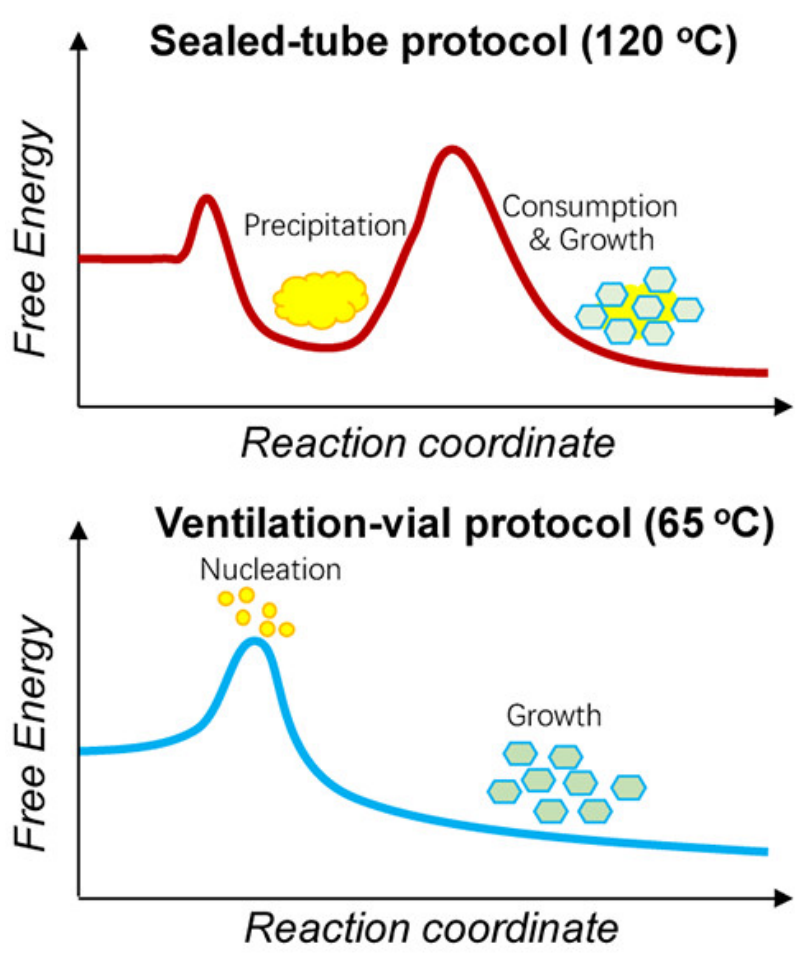
Figure 1. Two different processes for the synthesis of crystals. Reprinted (adapted) with permission from [28]. Copyright 2019 American Chemical Society.